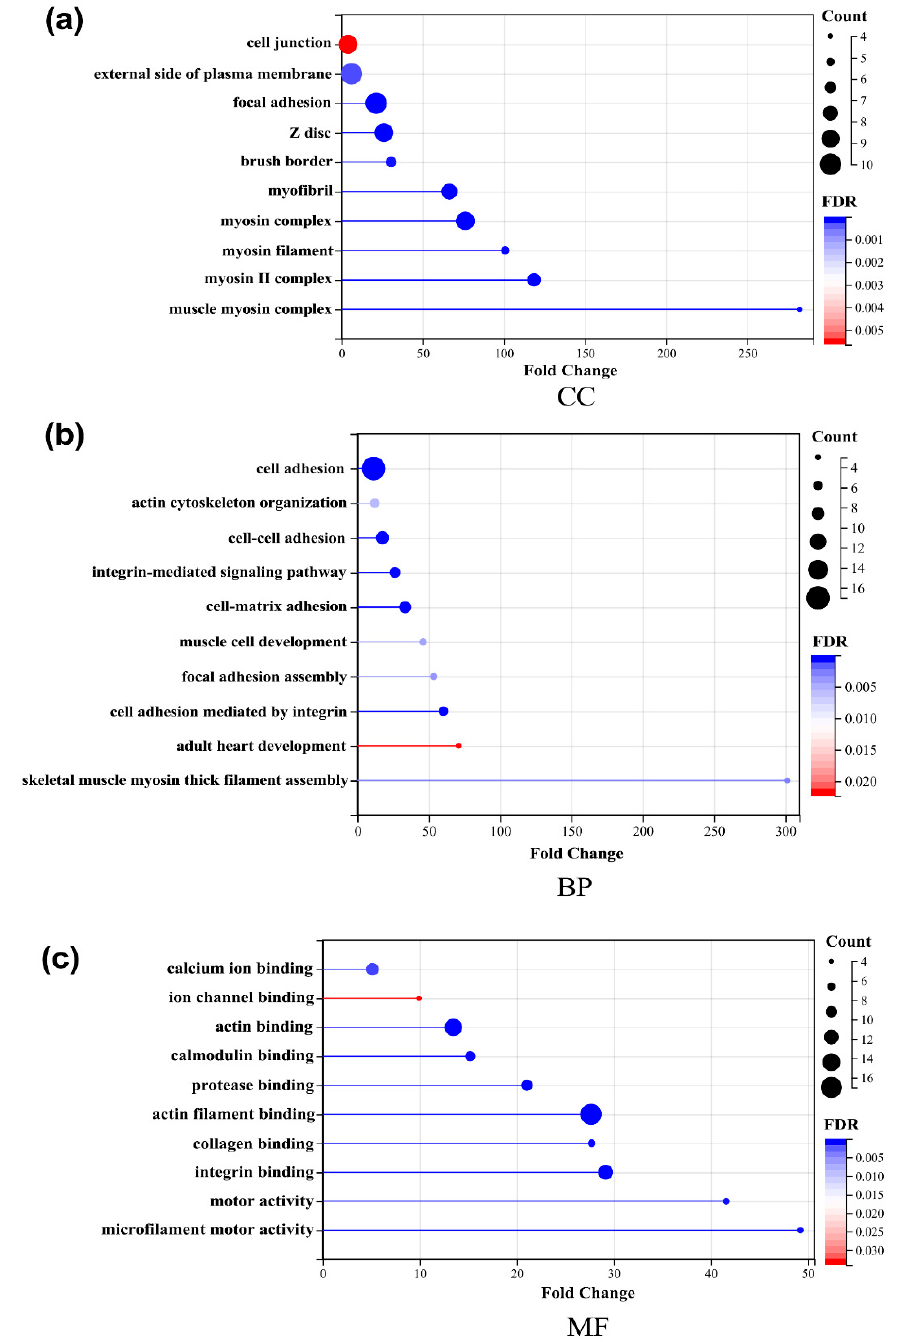
Figure 6. Gene ontology (GO) analysis of key proteins. Proteins were classified according to ( a ) the cellular component (CC), ( b ) the biological process (BP) and ( c ) the molecular function (MF) by DAVID (version 2021).